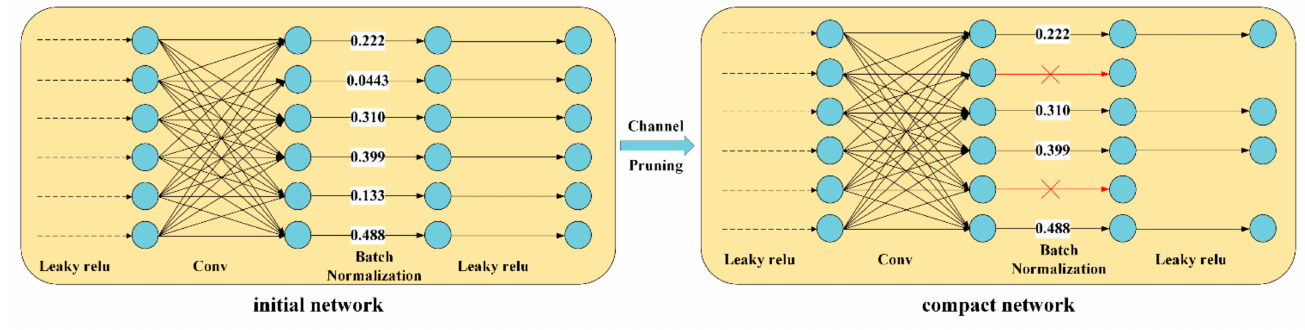
Figure 4. Schematic diagram of channel pruning algorithm.